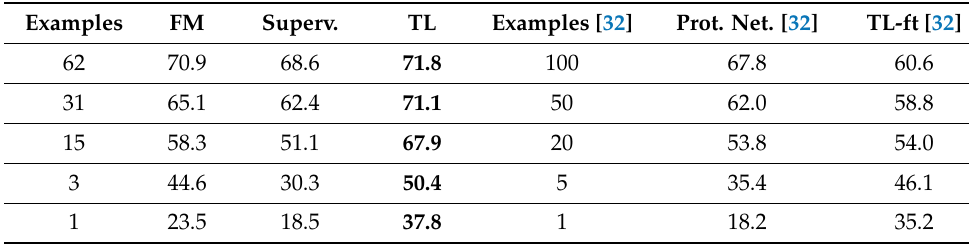
Table 5. Comparison of classification accuracy to Prototypical Networks (Prot. Net.) and TL with fine-tuning (TL-ft) reported in [32]. For a fair comparison, the next lower amount of labeled examples per class (“Examples”) from our experiments is